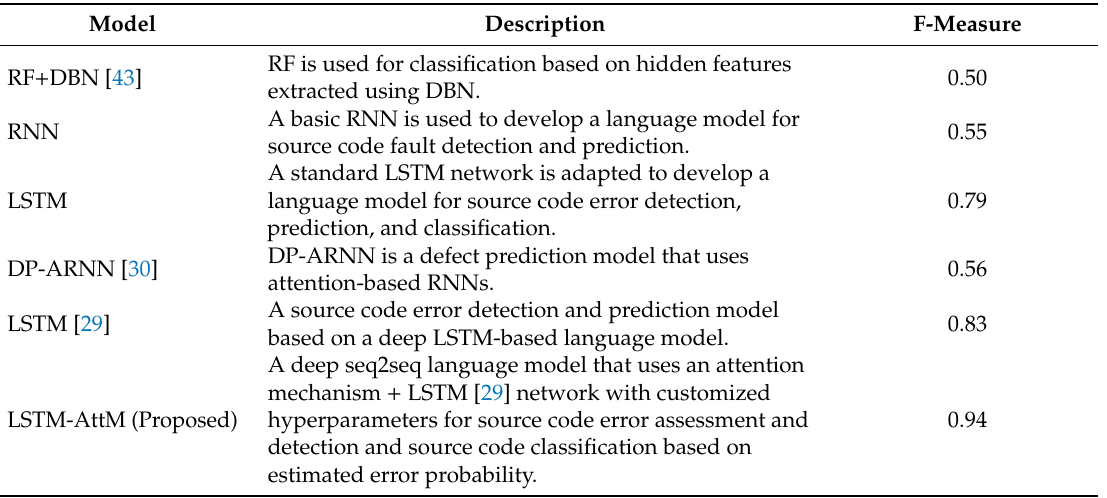
Table 9. Comparison with baseline models for defective source code